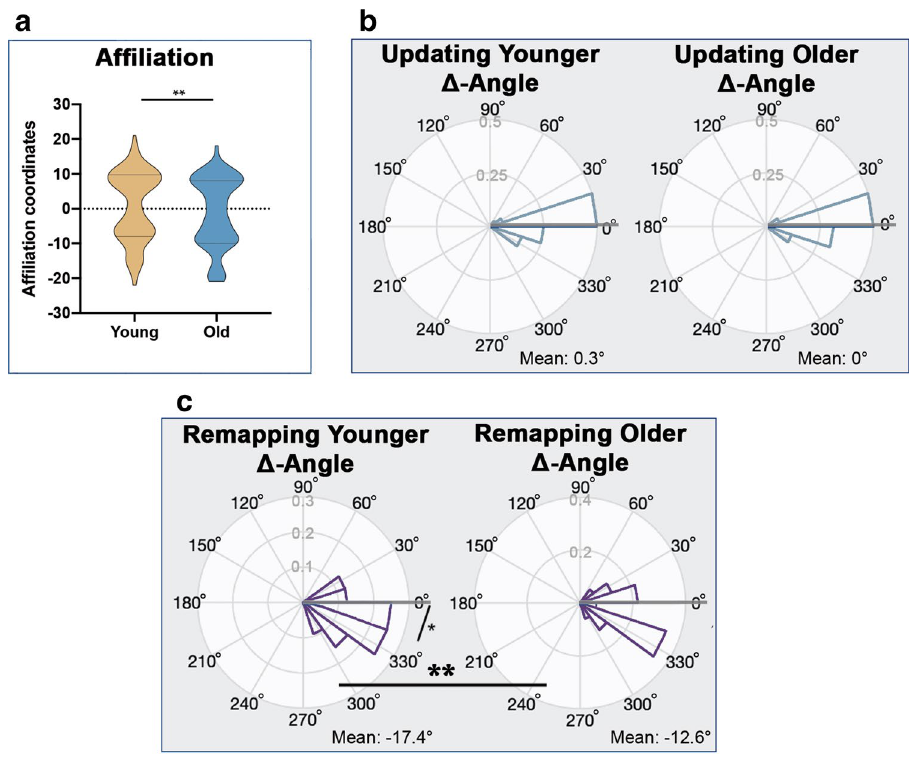
Figure 3. Updating and remapping of ‘social space’ in younger and older adults separately. ( a ) Main effect of age: older adults showed significantly lower affiliation-coordinates than younger adults. ( b ) There was no difference of updating-avatars median Δ-angles between agest. Also, younger and older participants’ median Δ-angles of updating-avatars were not significantly different from 0°. ( c ) The difference of remapping-avatars median Δ-angles between ages was significant. Further, median Δ-angles only significantly differed from 0° in younger adults, not in older